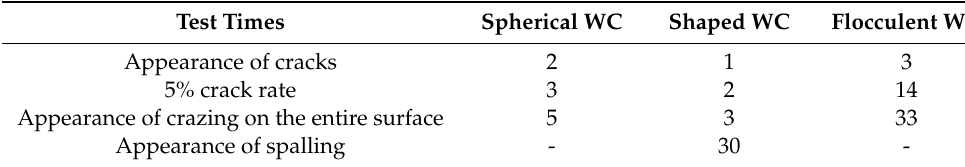
Table 4. Results of the thermal shock